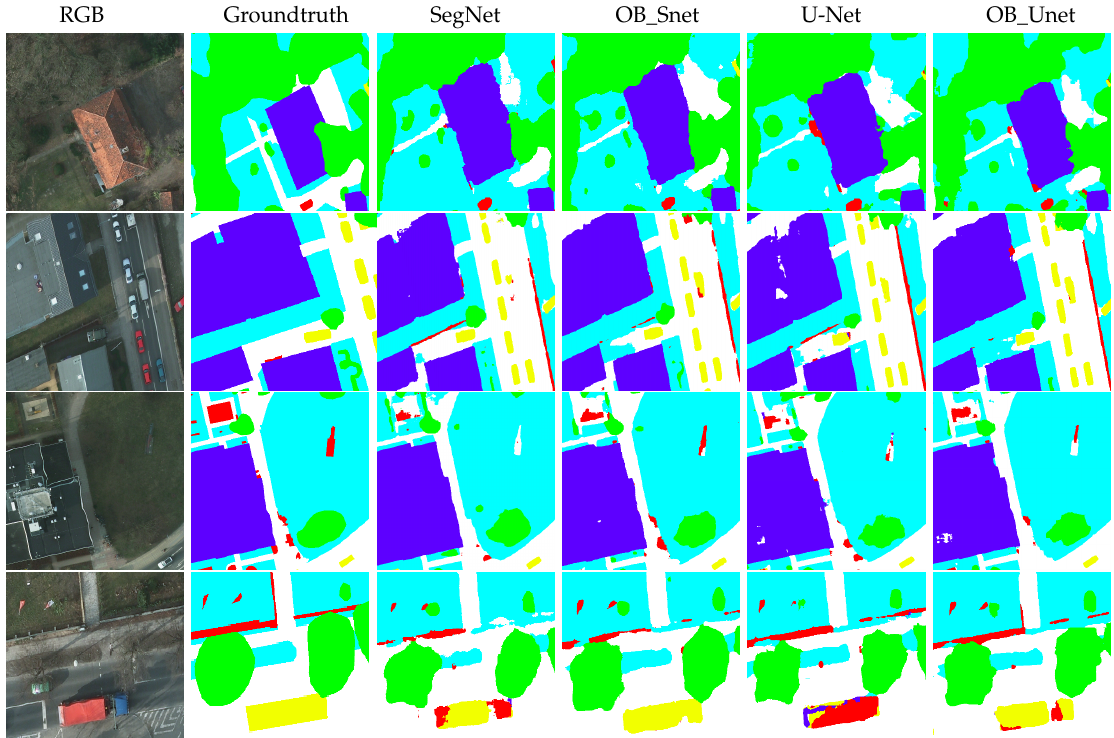
Figure 11. Experimental results from the developed OB_Snet and OB_Unet networks on indicative regions from the Potsdam dataset. The corresponding ground truth along with the results from the state-of-the-art SegNet and U-Net deep networks are presented as well (White, Impervious_Surfaces ; Blue, Buildings ; Light Blue, Low_Vegetation ; Green, Trees ; Yellow, Cars ; Red, Clutter